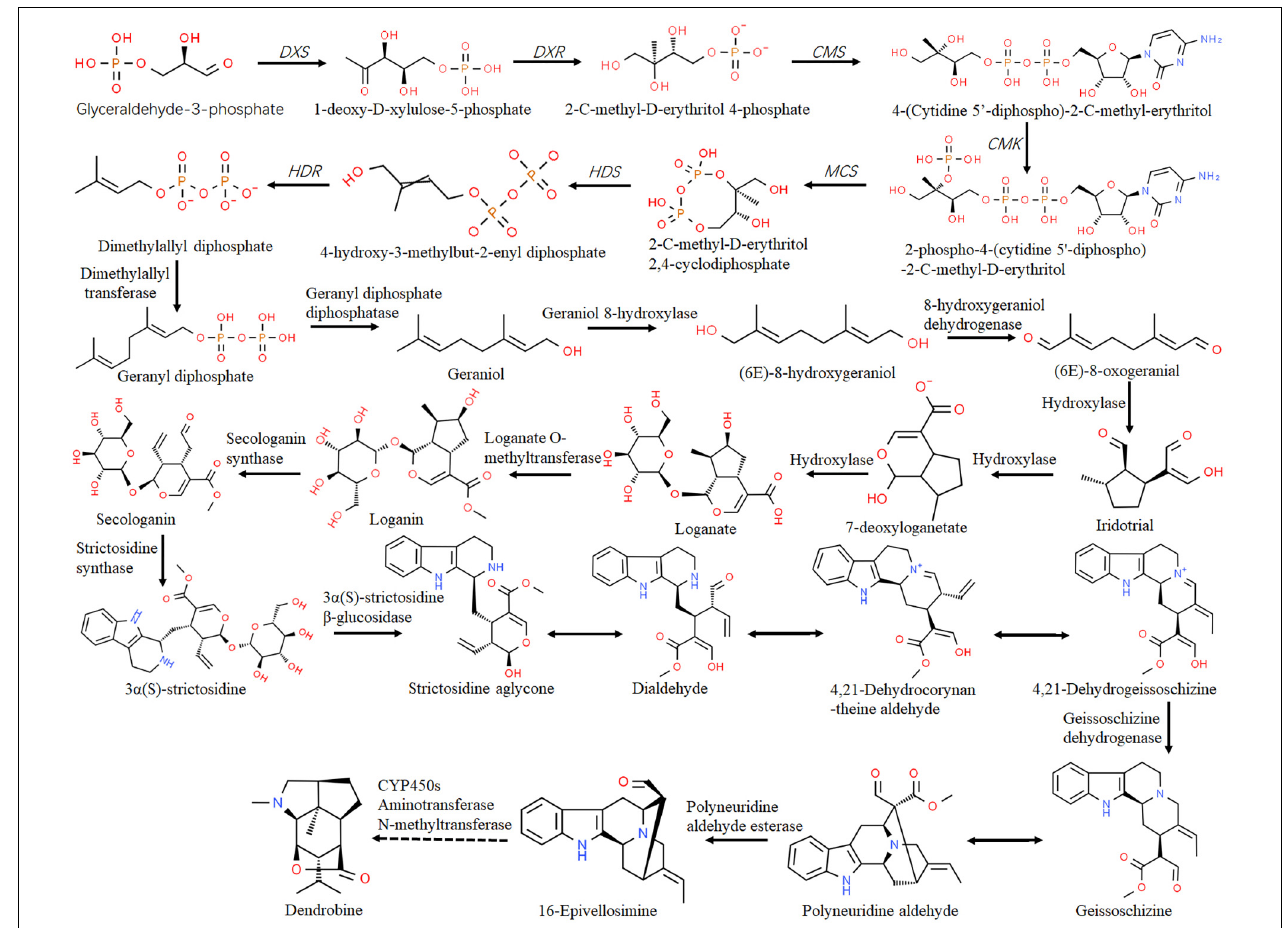
FIGURE 3 | Biosynthesis of dendrobine in Dendrobium through the MEP pathway. The putative pathway was adapted from Li Q. et al. (2017) and Zheng et al. (2018). The enzymes or enzyme encoding genes were indicated alongside the arrows. The dashed lines indicate multiple